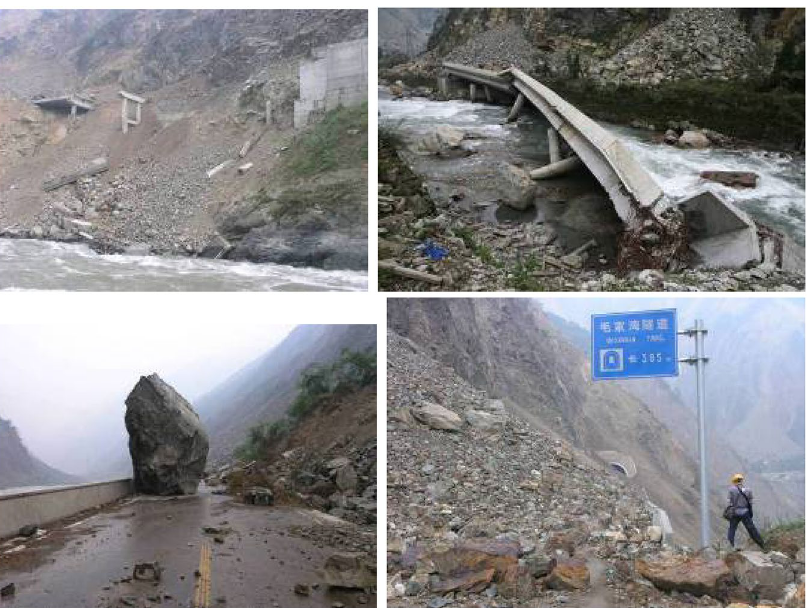
Figure 3. Slope rock mass landslide in 5.12 Wenchuan earthquake destroys a bridge, blocks the road, buries smashes tunnel entrance.